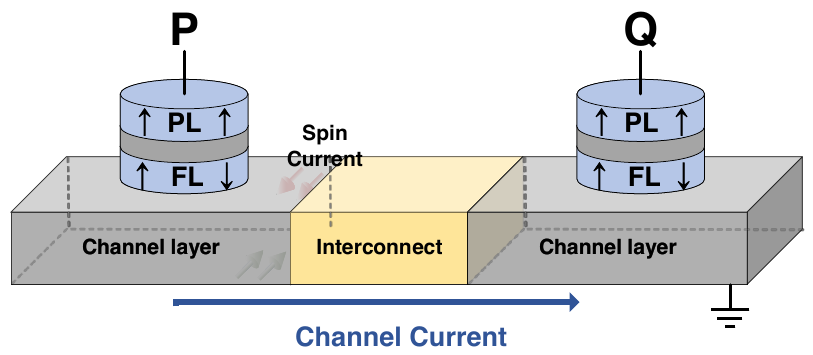
Figure 10. A spin logic device with two MTJs